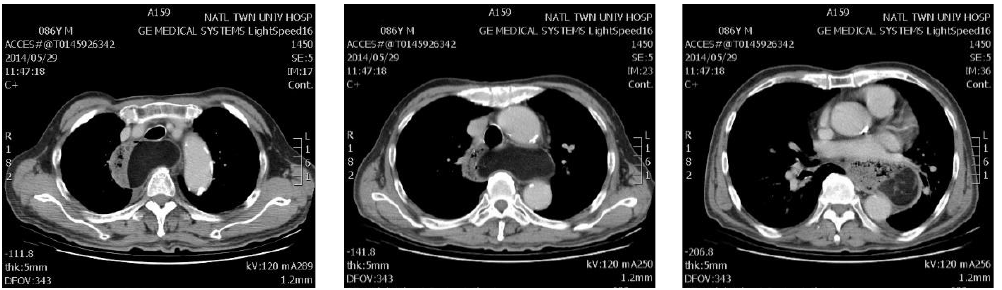
Figure 2. The CT (Computed Tomography) scan of the patient with giant lipoma of 22 cm in diameter (case 4). He received robotic-assisted tumor excision and was discharged 12 days after surgery. The median length of hospital stay was 11 days (range 5 – 53). Post-operative compli- cations were noted in three (15.8%) patients: one with sepsis, another with chylothorax, and the third with GI bleeding, hiatal hernia, and stroke. There was no mortality. The median interval between surgery and liquid intake was 5 days after water-soluble contrast medium (hypaque) swallow showed no leakage. A soft diet was then tried the next day, and chest tubes were withdrawn on the third day. Imatinib mesylate (Glivec) was administered to patients with pathologically con- firmed GISTs for disease control. The median follow-up time was 35 months (range 1 – 74). No long-term complications were observed, including tumor recurrence, diverticulum, or stricture. 4. Discussion Our study is the largest case series to date on robotic-assisted thoracoscopic enucle- ation of esophageal mesenchymal tumors and cysts. There have been 35 cases reported to date (Table 1) [3,6 – 8,10 – 21]. In total, 22 (62.8%) patients were diagnosed with leiomyoma, 6 (17.1%) patients had foregut cysts, and 1 (2.8%) patient had schwannoma. The tumor size ranged from 2 cm to 10 cm, with the locations distributed evenly from the upper to lower esophagus. Only one patient had complications: an esophageal fistula after the op- eration. No intraoperative mucosal damage was described. Similar to the previous data, we presented 19 cases, with more than half being leio- myoma. However, apart from foregut cyst and schwannoma, we also reported four cases of malignant GISTs, one lipoma, and one granular cell tumor. We had a wider tumor size range (1.5 cm – 22 cm). More than half of them were located in the lower esophagus. In- traoperative mucosal damage was noted in two patients with GISTs adhesive to the mu- cosa. Enucleations were all converted to subtotal esophagectomy for malignancy treat- ment. Leiomyoma is the most common esophageal mesenchymal tumor, which accounts for about 70 – 80% of all esophageal mesenchymal tumors. It is hard to distinguish it from GISTs through preoperative imaging, accounting for another 15% – 25% of esophageal mesenchymal tumors [27]. Other rare entities, including schwannomas, hemangioma, li- pomas, leiomyosarcoma, papillary epithelioma, and granular cell tumors, account for less than 5% of all esophageal mesenchymal tumors [28]. It is essential to differentiate GISTs from leiomyoma, since GISTs are considered ma- lignant. However, this differentiation cannot be done using CT, EUS, and 18F-fluorode- oxyglucose positron emission tomography [29]. The golden standard for differentiation is a pathological examination, including hematoxylin and eosin staining, and immunohisto- chemical studies [30]. To obtain enough tissue for diagnosis, core biopsy and fine needle aspiration were performed in some cases. However, they are not recommended due to the increased risk of operative mucosal perforation caused by fibrosis and the adhesion be- tween the mucosa and the tumors [31]. Moreover, fine needle aspiration is insufficient to provide enough tissue for differentiation, and risks tumor seeding [32].